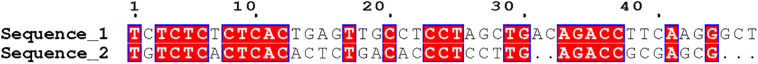
Non-isometric DNA sequence alignment diagram.